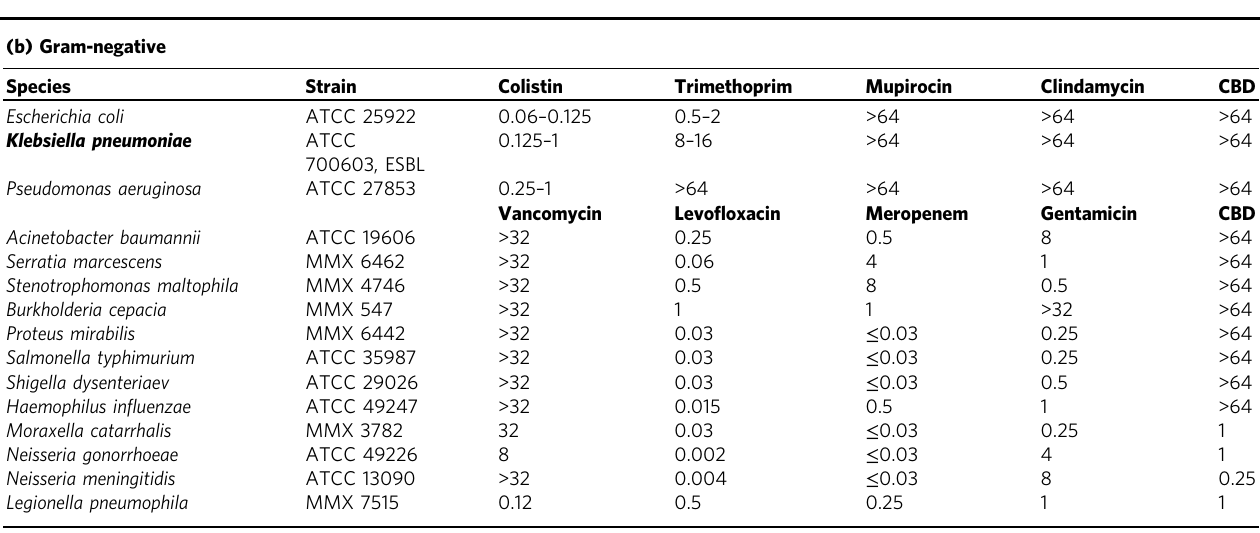
Table 10). Synergy was not observed with other classes of antibiotics, including glycopeptides (teicoplanin), various types of β -lactams (ceftazidime, cefepime aztreonam, meropenem), and a different type of membrane-active peptide antibiotic, the β -hairpin antimicrobial peptide arenicin-3.